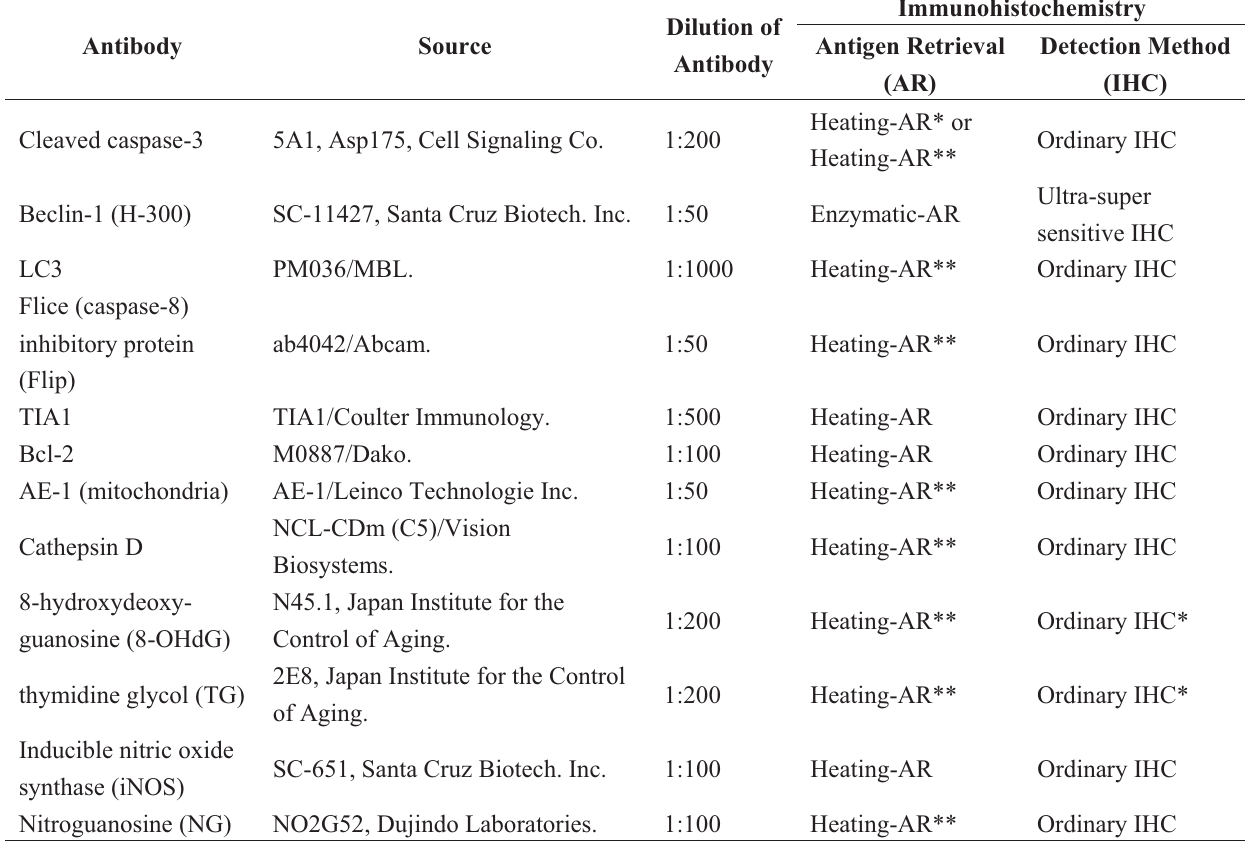
Table 1. Antibodies and their immunohistochemical detection